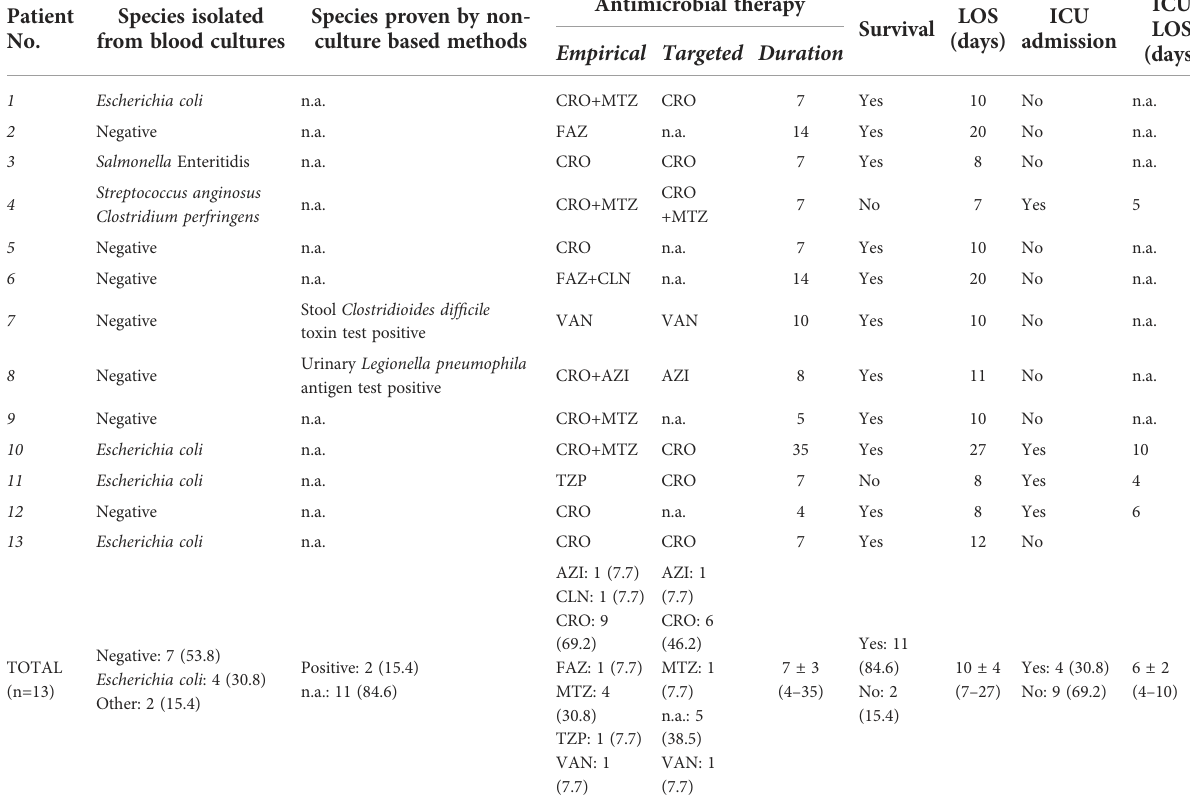
Antimicrobial therapy